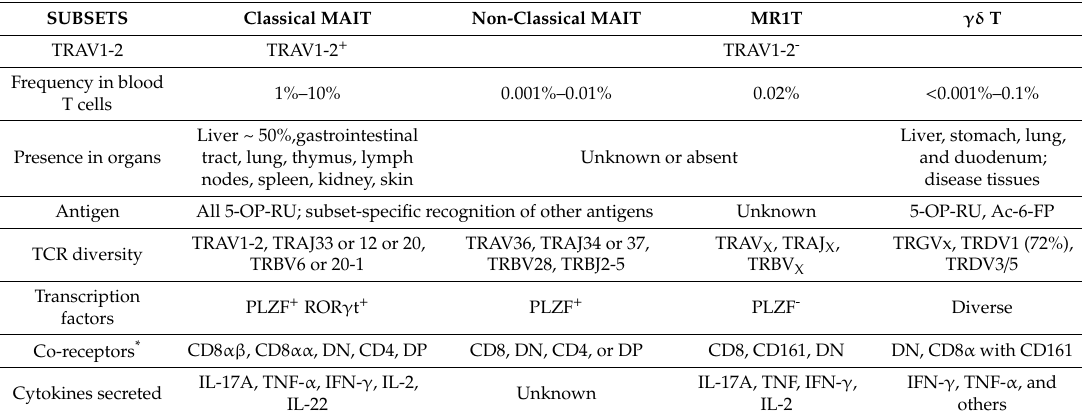
Table 1. Main Characteristics of Subsets of Human MR1-restricted T cells.